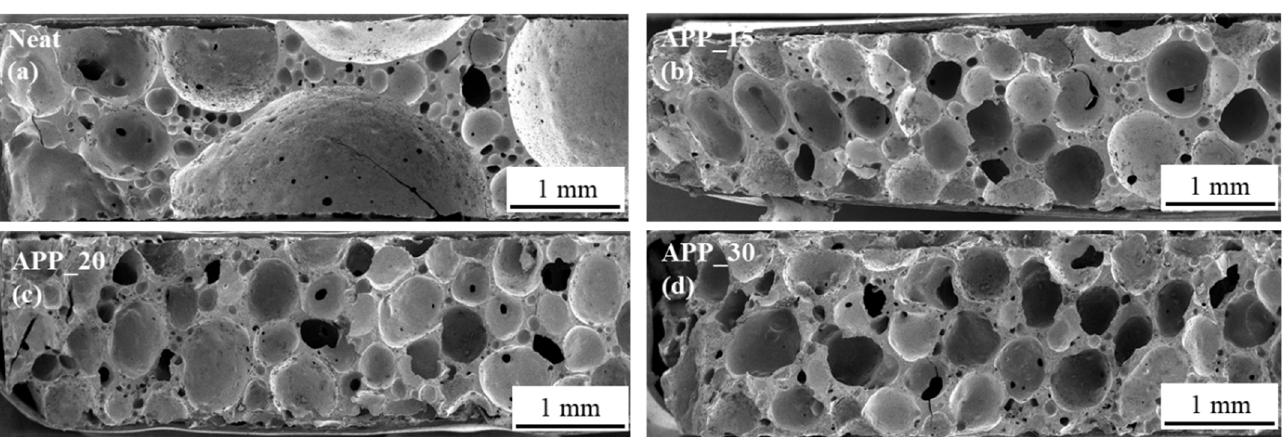
Figure 5. SEM images taken von EN/B-IPDA foams without particle modification, Neat ( a ), with APP 15 wt.% ( b ), 20 wt.% ( c ), 30 wt.% ( d ).